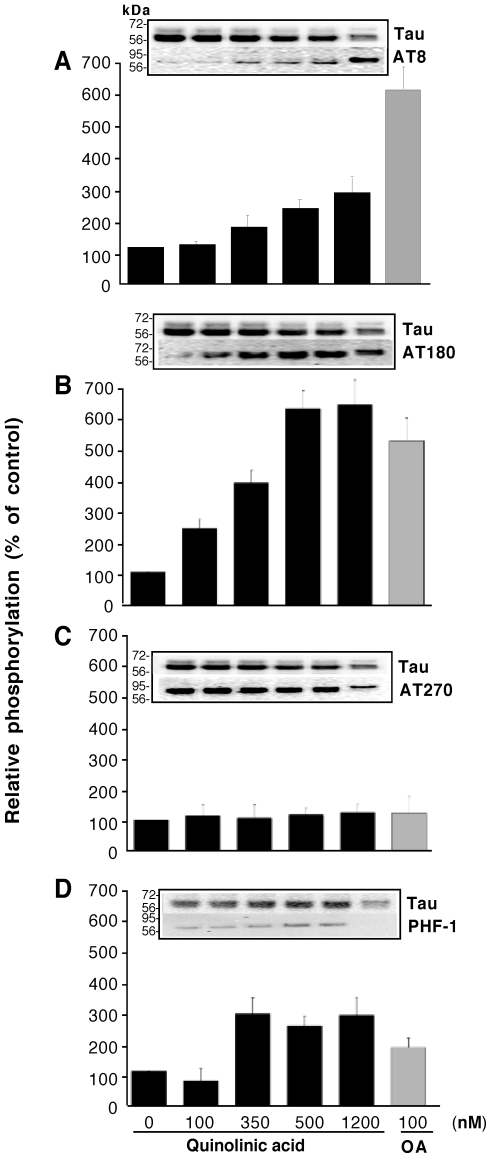
QA induces tau phosphorylation at multiple serine and threonine residues:Primary human foetal neurons were cultured at a density of 1×106 cells per well in a 12-well plate in the absence or presence various concentrations of QA. 100 nM Okadaic acid was used as positive control for tau phosphorylation. After 72 hours, cells were lysed in RIFA buffer. The lysate protein resolved in 10% SDS-PAGE and Western blot performed with the antibodies indicated. Antibodies tested are: A, AT8 (1∶1000 dilution); B, AT180 (1∶1000); C, AT270 (1∶2000); D, PHF-1 (1∶1000). Signal for total tau was determined with the antibody Tau at 1∶1000 dilution. Blots were quantified using the Quantity-One software (Biorad). Signal for phospho tau epitopes was normalized by the signal for total tau and the data expressed as percent of the normalized signal in control cultures. Data presented are the mean (±SD) of five different experiments with neurons from five different brains. Each graph is accompanied with a representative blot in which lane 1 is control; lane 2, 100 nM QA; lane 3, 350 nM QA; lane 4, 500 nM QA; lane 5, 1200 nM QA; lane 6, 100 nM Okadaic acid.